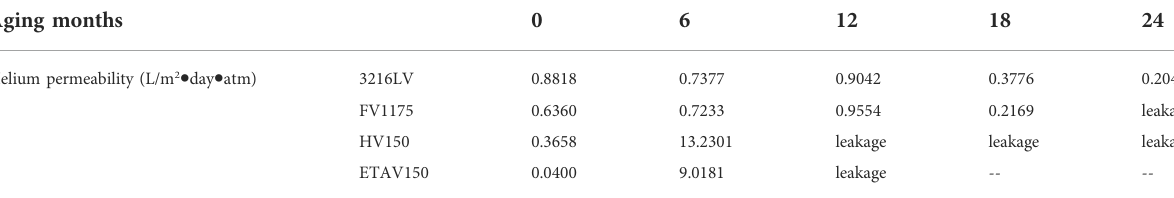
TABLE 3 Helium permeability of envelope materials. Aging months